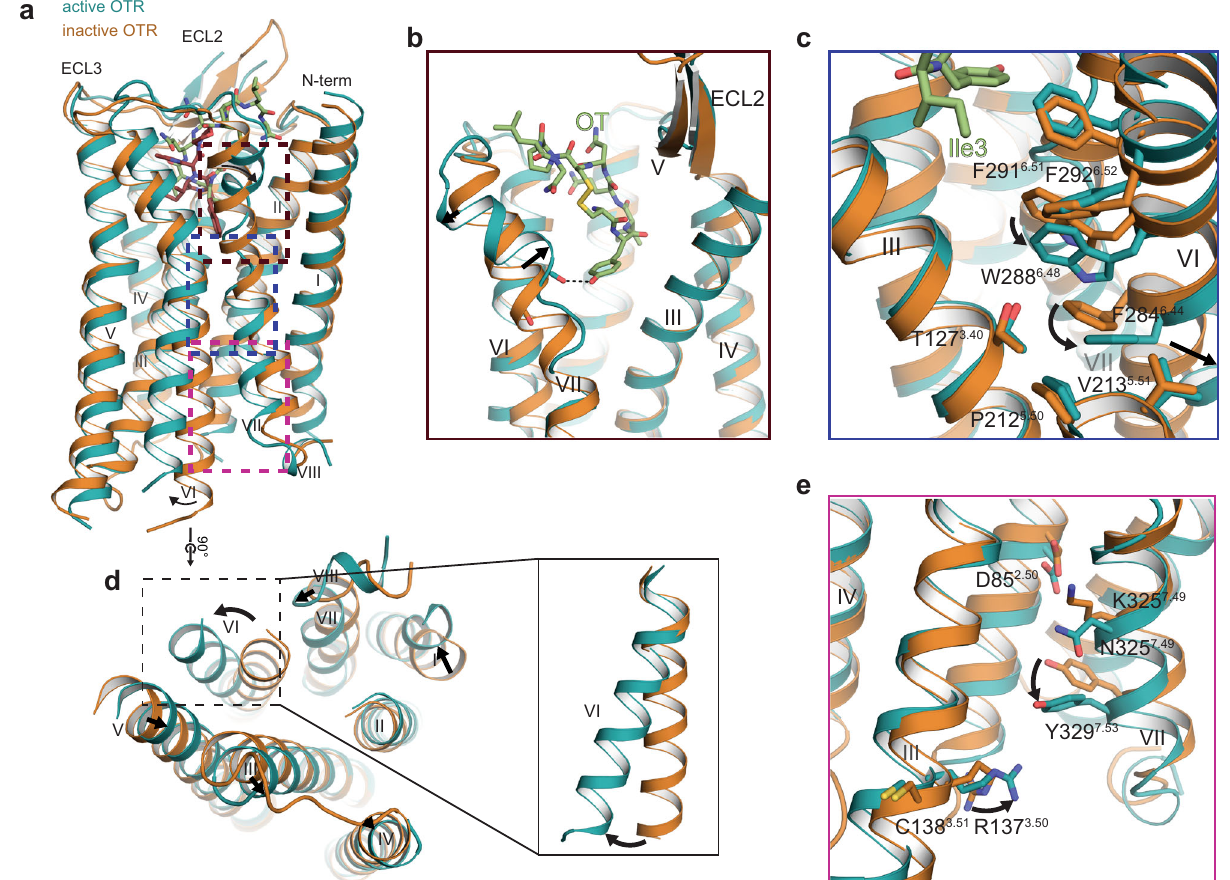
Fig. 3 Activation mechanism of OTR. a Molecular mechanism of OTR activation. Superposition of active (teal, this study; PDB 7QVM) and inactive OTR (orange, PDB 6TPK). b Close-up on kink in helix VII. Hydrogen bond between OTR and OT is indicated by dashed black line. c Close-up view on class A-speci fi c microswitch motifs CWxP and PIF. Arrows indicate shifts of microswitch residues from inactive to active state. d Intracellular view of super- positioned receptors with additional close-up view on helix VI. Arrows indicate shifts of the intracellular helix tips from inactive to active state. e Close-up view on class A-speci fi c microswitch motifs DRC and NPxxY. Arrows indicate shifts of microswitch residues from inactive to active